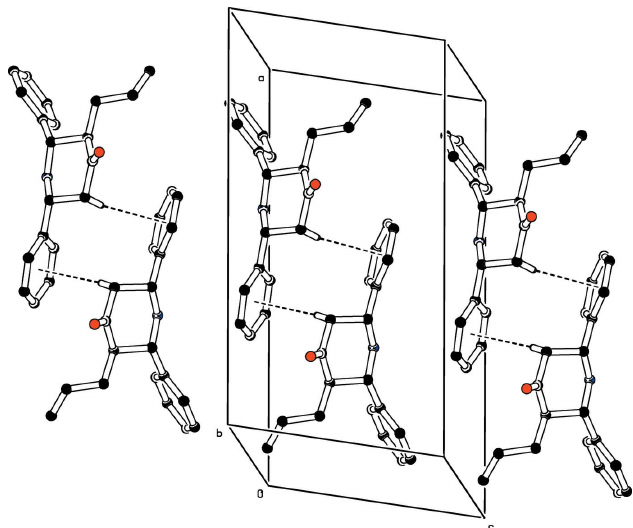
Figure 2 The crystal packing of the title compound viewed along the b -axis direction. The C—H (cid:3)(cid:3)(cid:3) (cid:2) interactions are shown as dashed lines. For clarity H atoms not involved in these hydrogen bonds have been